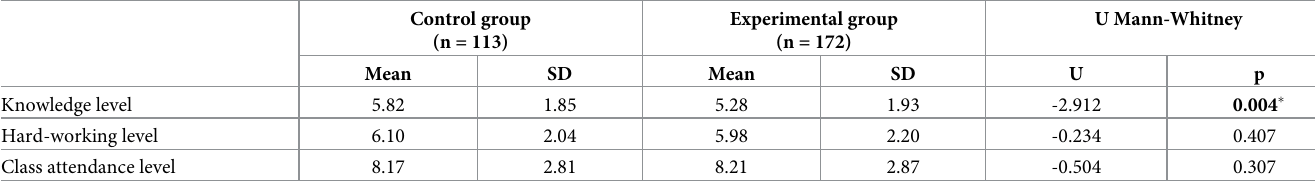
Table 2. Students’ characteristics: Experimental vs. control